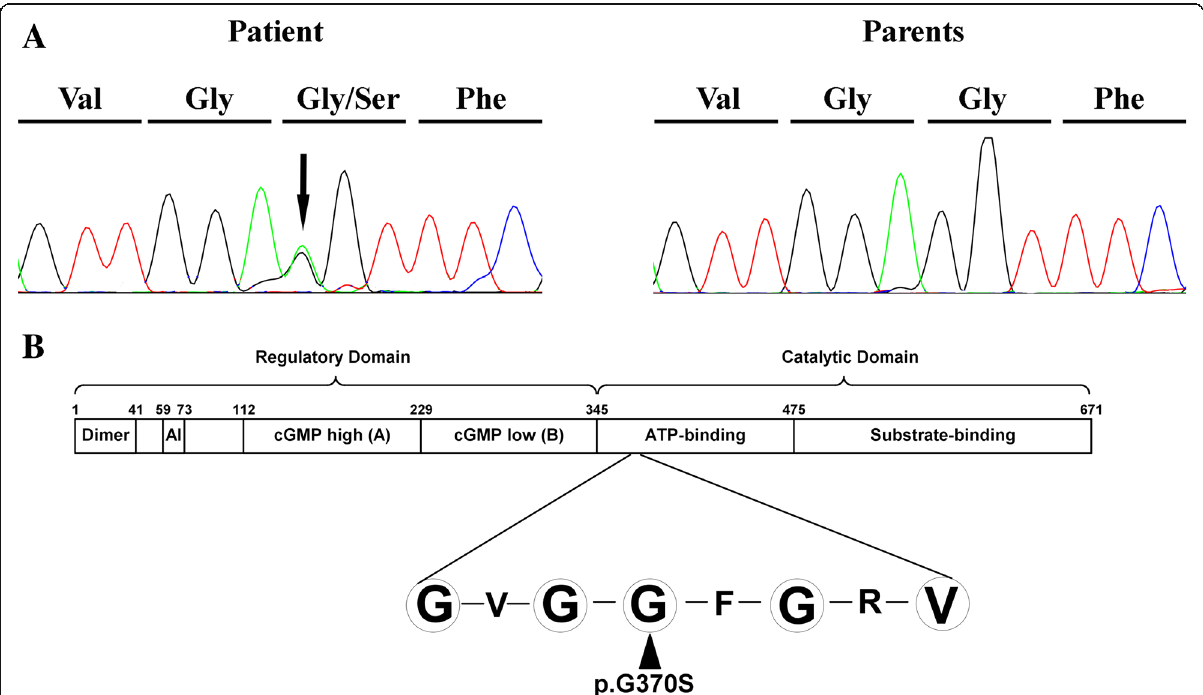
Fig. 2 Sanger sequencing and mutation location. a The DNA sequencing chromatograms represent the patient and his parents. The corresponding encoded amino acid is shown above the chromatograms and the arrow denotes the mutated nucleotide. b A graphic illustration of the functional domain structure of PKG-1 α and the glycine-rich GXGGXXGXV motif where the mutation p.Gly370Ser is located, as indicated by triangle. At the N-terminus, the dimerization domain is depicted. AI = the auto-inhibition domain; cGMP high (called A) = high-affinity binding domain for cGMP; cGMP low (called B) = low-affinity binding domain for